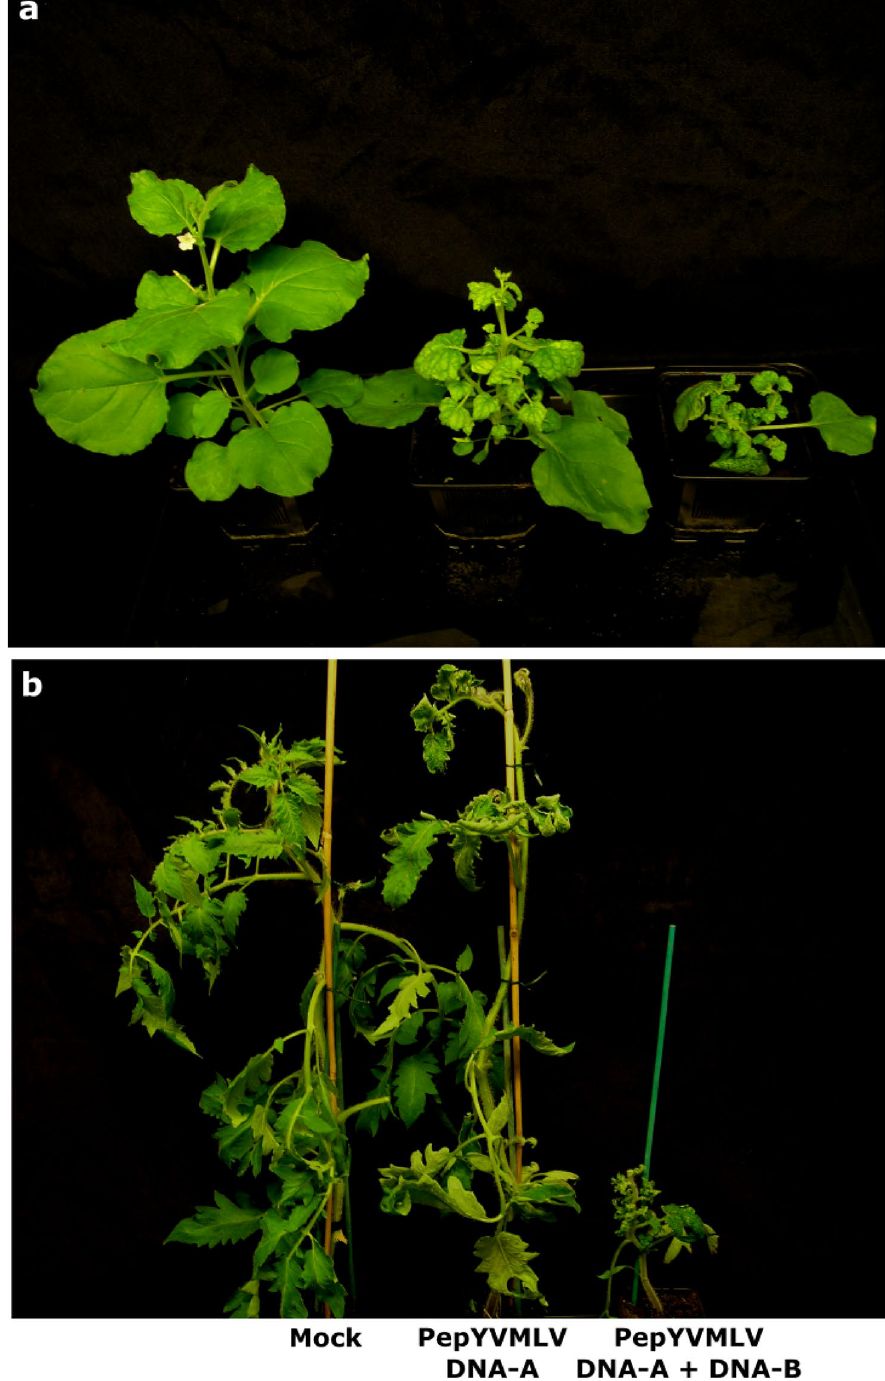
Figure 1. Disease symptoms in ( a ) Nicotiana benthamiana and ( b ) tomato ( Solanum lycopersicum ) plants agroinoculated with mock, PepYVMLV in single (DNA-A) or mixed (DNA-A and -B) infection at 29 days post inoculation. Distinct symptoms of leaf crumpling with yellowing and stunting were observed between single (mild symptoms) and mixed (very severe symptoms) infections on both N. benthamiana and tomato